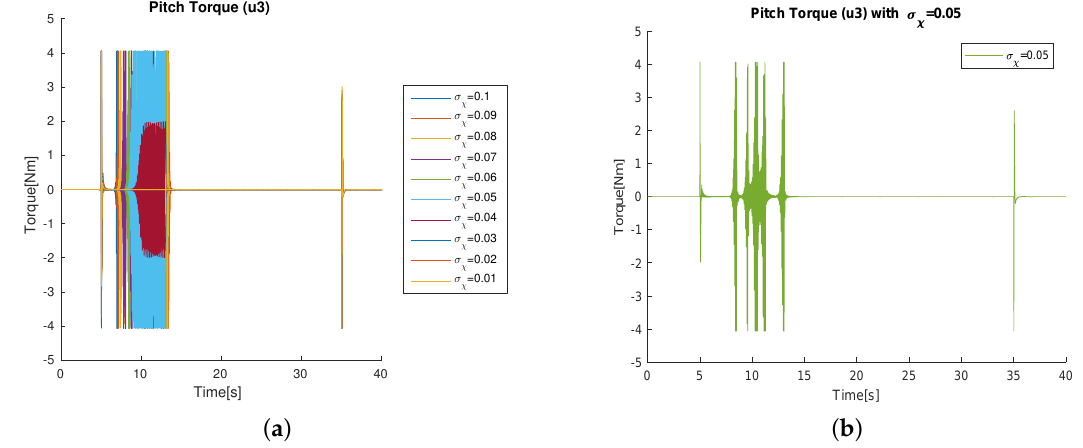
Figure 25. ( a ) Pitch Torque with distinct σ χ ’s; ( b ) Pitch Torque with σ χ =